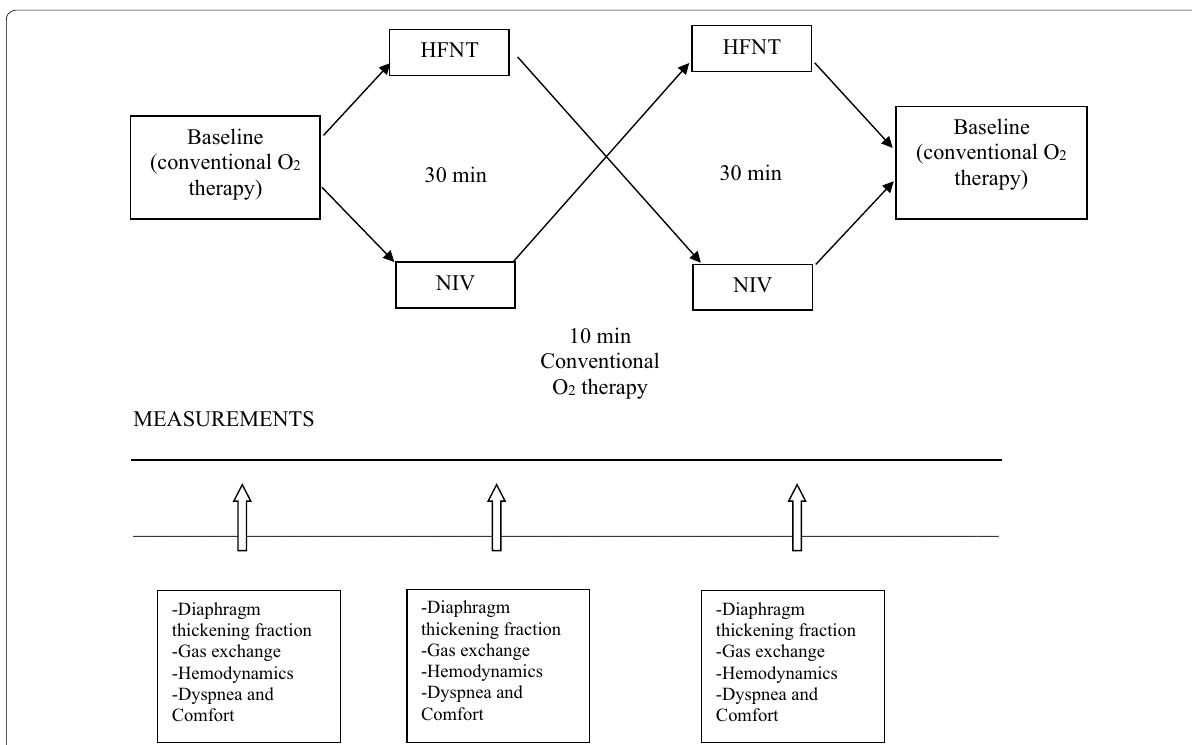
Fig. 1 Study design. Fifteen cystic fibrosis patients were oxygenated with high-flow nasal cannula and noninvasive ventilation for 30 min each in random order with a 10-min washout period after each device use. All measurements were taken at baseline and after 25 min on each device. HFNT high-flow nasal therapy, NIV noninvasive